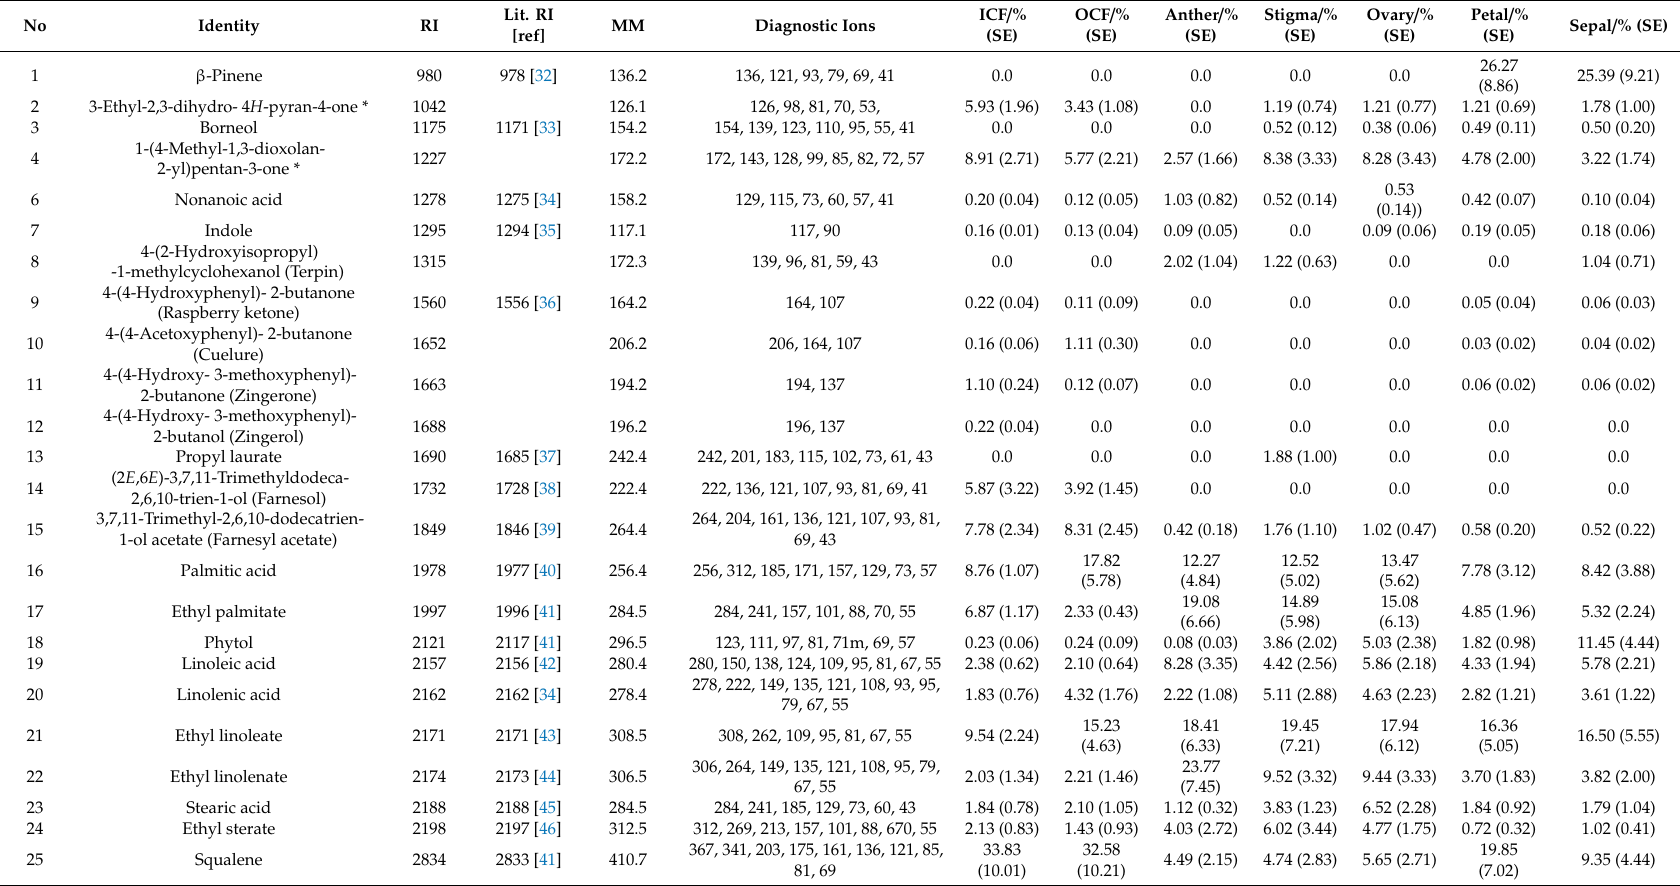
Table 1. Chemical profiles of the seven assessed flower parts of P. maliformis . Relative abundances of chemicals were calculated by dividing the gas chromatography (GC) peak area of a compound by the sum of total peak areas of all compounds; The relative abundances were obtained from the 7 am samples; * Tentatively identified compounds, further information is in the Supplementary Material; RI: Kovats retention index; Lit. RI: Literature retention index; ref: references for retention index with most similar GC conditions.; MM: molecular mass; ICF: inner coronal filament; OCF: outer coronal filament; SE: Standard